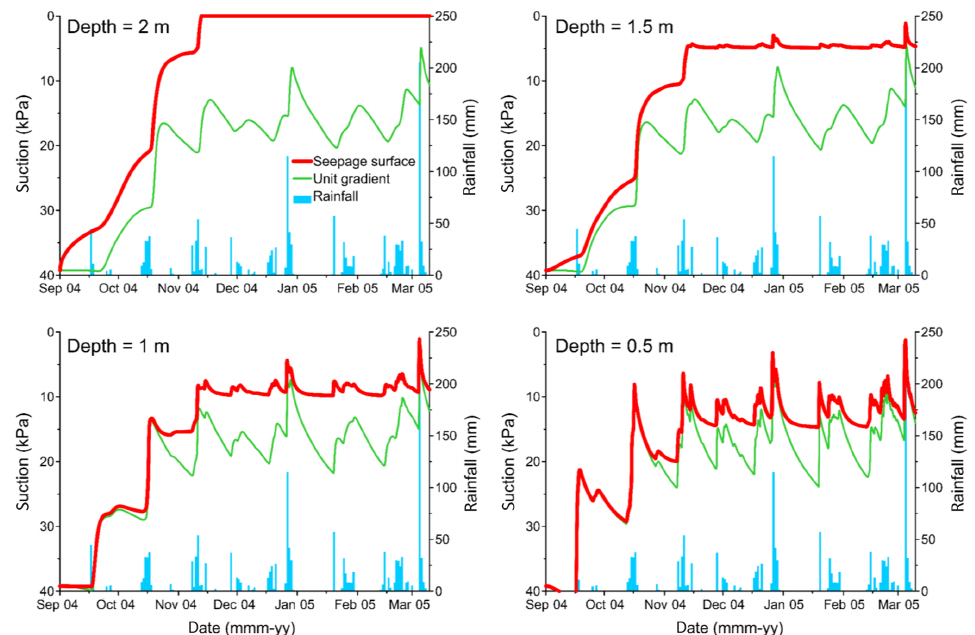
Figure 7. Prediction of suction evolution over the hydrological year of the Nocera Inferiore 2005 landslide at four different depths and for two different hydraulic conditions at the lowermost boundary (Reder et al., 2017,